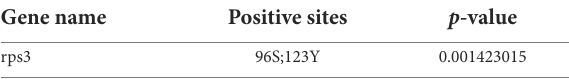
TABLE 3 Positively selected genes and sites detected in the chloroplast genomes of Isoetes